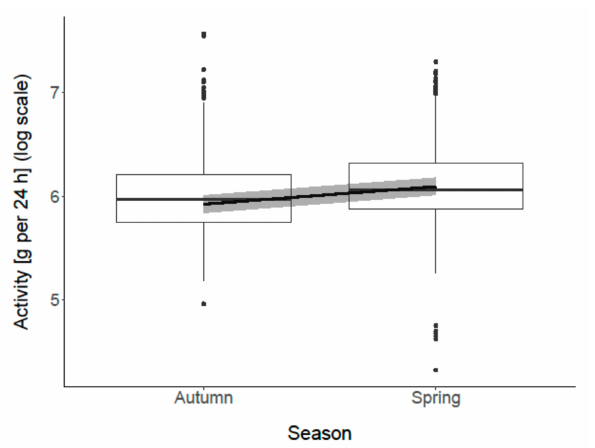
Figure 9. Association between “season” and goats’ activity (per 24 h). Activity (g = m/s 2 ) is log transformed. Box plots show medians and interquartiles. The black line represents the model estimate, the gray colored area the 95% confidence